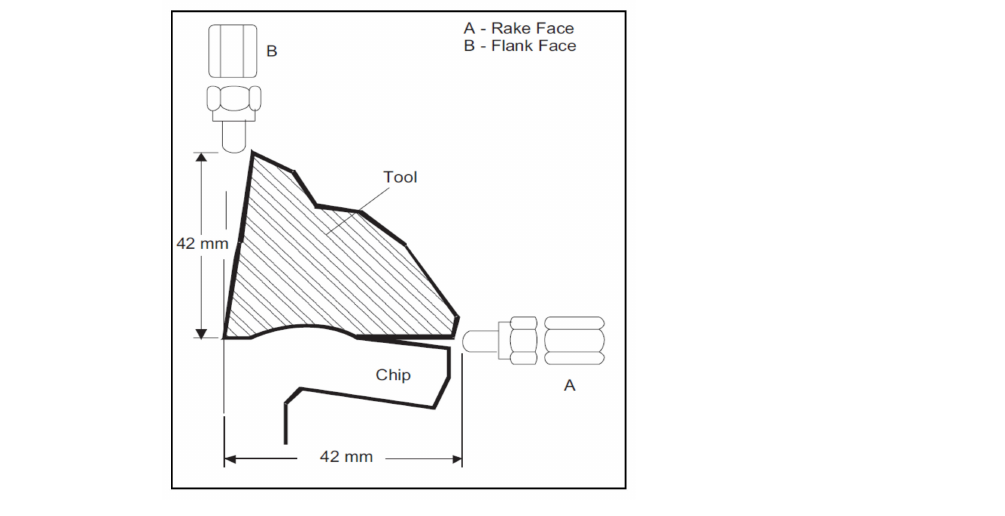
Figure 34. Position of the tool with respect to the workpiece, reprinted with permission from ref. [182]. Copyright 2006 Elsevier